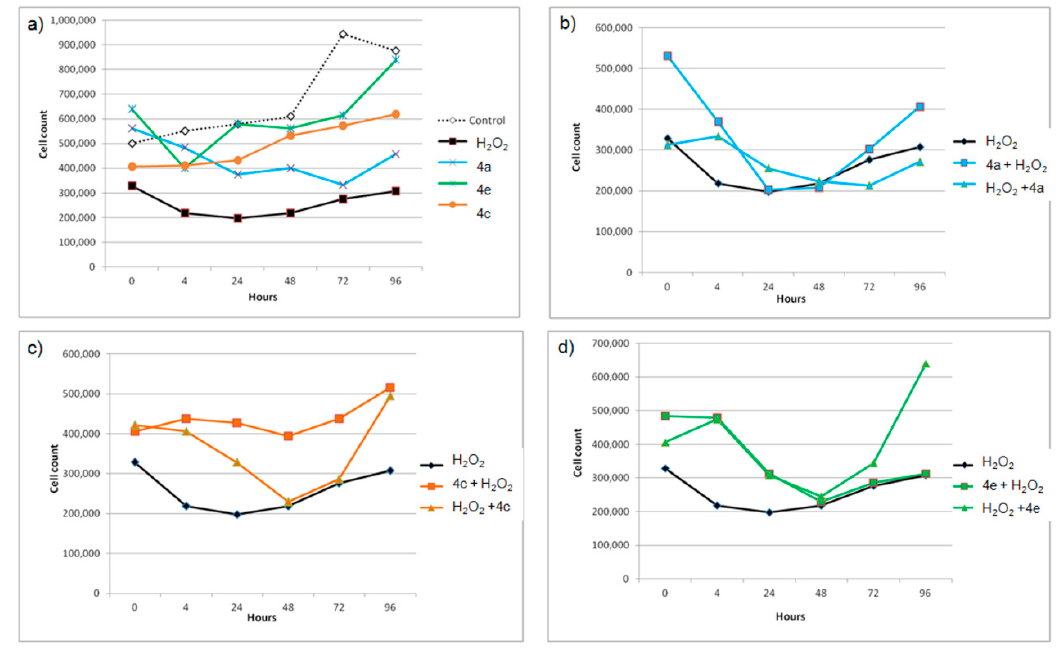
Figure 2. ( a ) The effects of the radical scavengers 4a, 4c and 4e and the oxidant H 2 O 2 on the growth of THP-1 cells cultured for 96 h; ( b – d ) the effects of the compounds given 30 min either before (compound + H 2 O 2 ) or after (H 2 O 2 + compound) H 2 O 2 on the THP-1